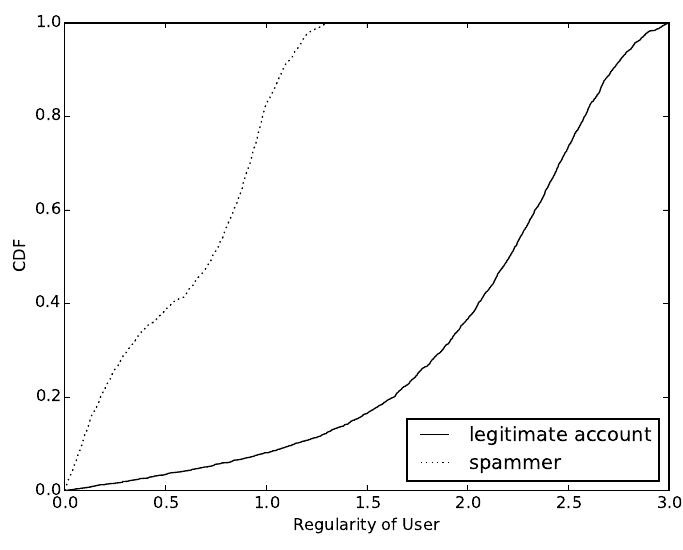
Figure 5. Regularity of users’